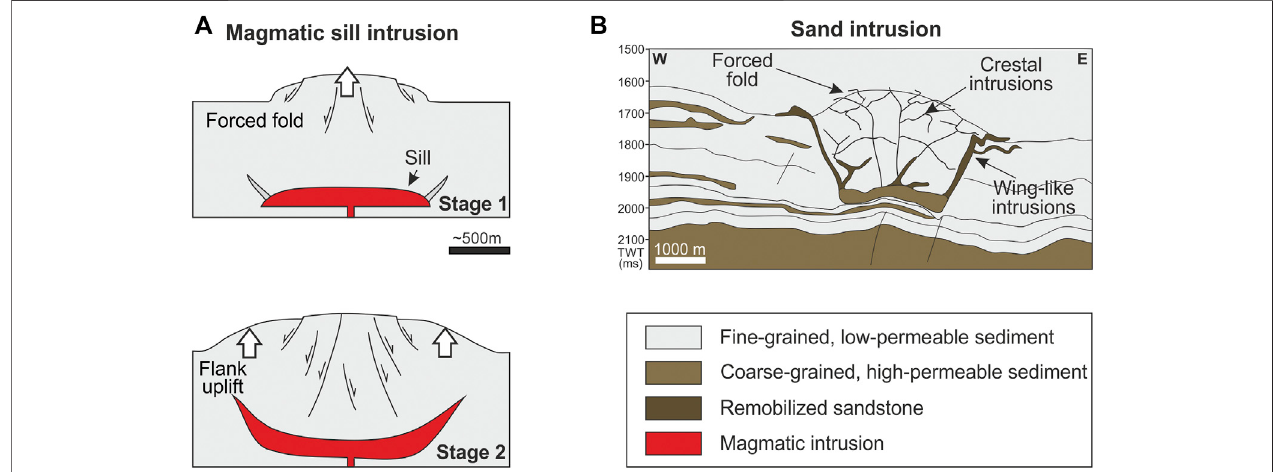
FIGURE1| Examples ofprocesses leadingtoforced foldingand associated fracture patterns. (A) Two-stage evolution ofoverburden deformationpatterns during a magmatic sill-to-inclined dyke transition of a shallow level magmatic intrusion (modi fi ed from Hansen and Cartwright, 2006). Stage 1: Formation of a forced fold associatedwithtensilefracturesattheperipheryofthesill.Stage2:Sillintrusionsintoperipheralfractures. (B) Crestalfracturesandwing-likeintrusionsaboveanisolated sand body, which is surrounded by low-permeable fi ne-grained sediments (modi fi ed from Huuse et al., 2007).